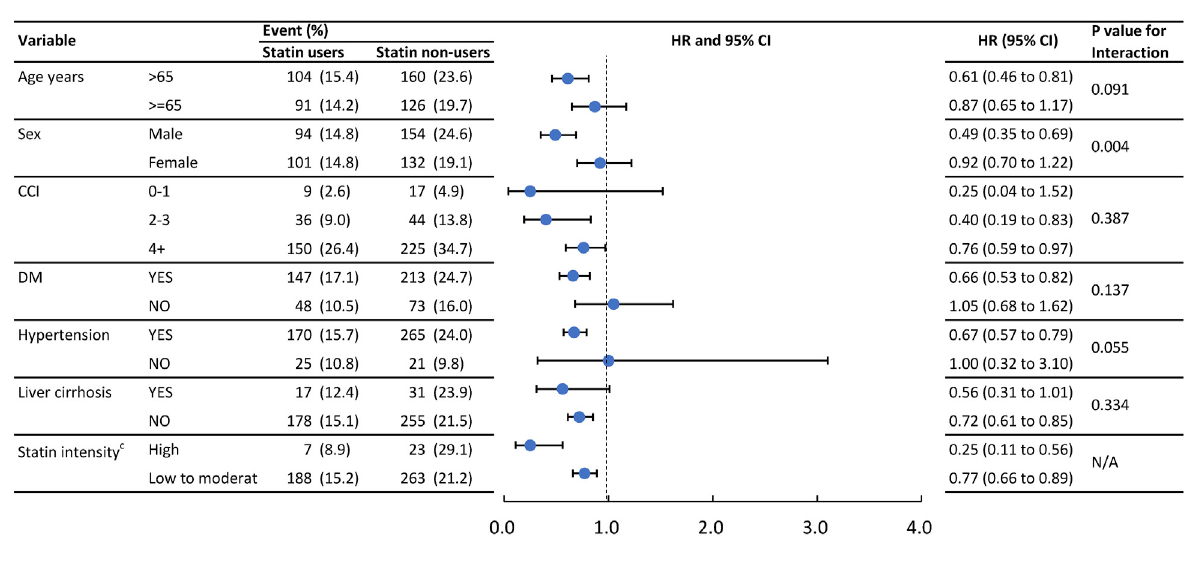
FIGURE 4 Event numbers and hazard ratios of the MACE between statin users and statin